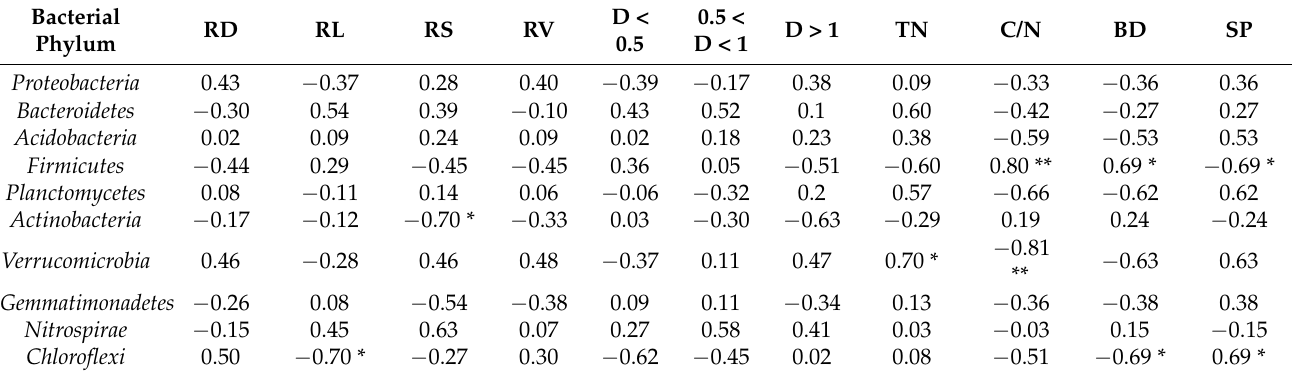
Table 4. Correlations between dominant bacterial phyla, root characteristics, and soil